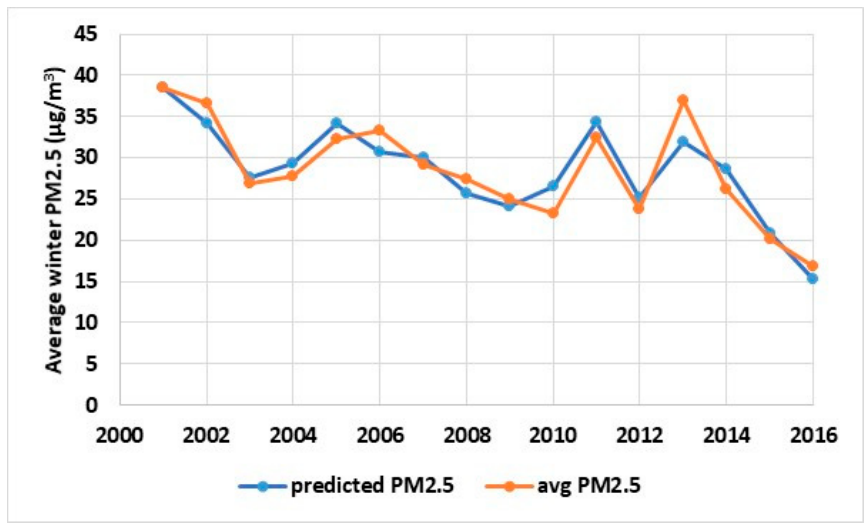
Figure 12. Winter average measured and regression predicted PM 2.5 at Fresno-Garland for the winters